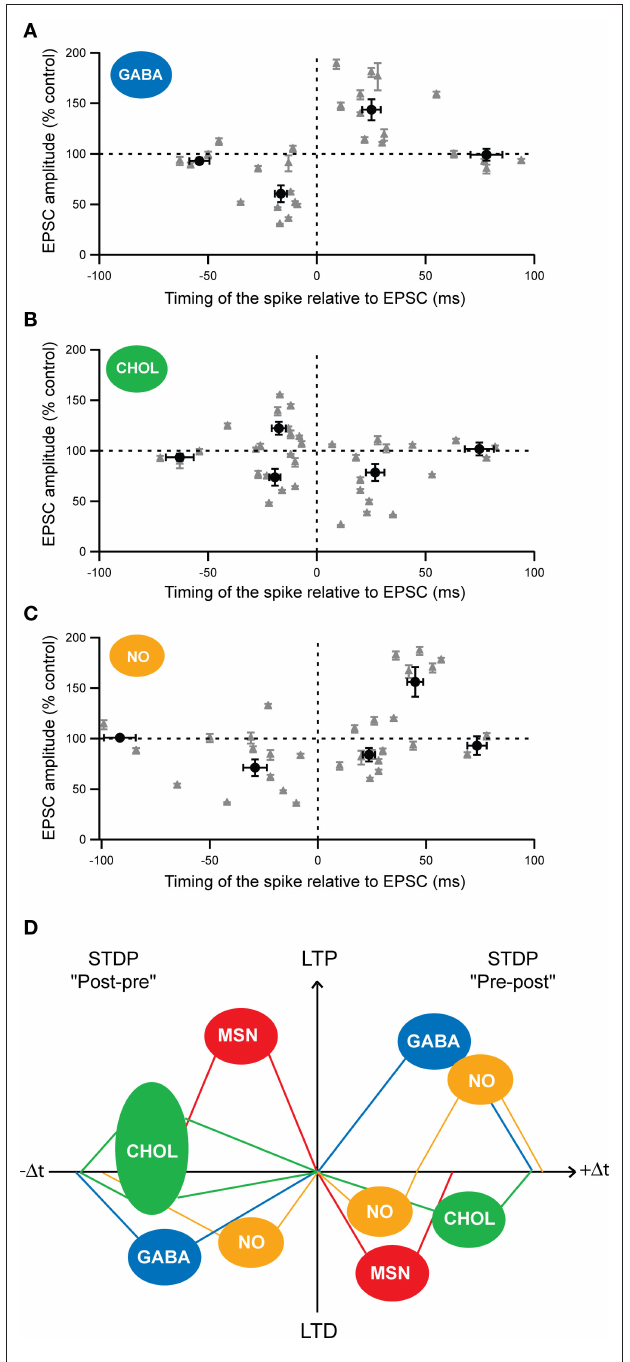
FiGure 4 | Cell-specificity of the STDP among MSNs and striatal interneurons. (A–C) Spike-timing dependence of the STDP for the different striatal interneurons: (A) fast-spiking GABAergic interneurons (GABA), (B) cholinergic interneurons (CHOL) and (C) nNOS interneurons (NO). Each recorded neuron is represented by a gray triangle and the averages ( ± SEM) of the synaptic efficacy changes 1 hour after the STDP paired protocol are indicated by the black dots. (D) Schematic representation of the cell-specificity of the spike-timing dependence of STDP developed by the different striatal neurons after post-pre (left) or pre-post (right) pairings (100 paired stimulations at 1 Hz). (Adapted from Fino et al., 2005, 2008,